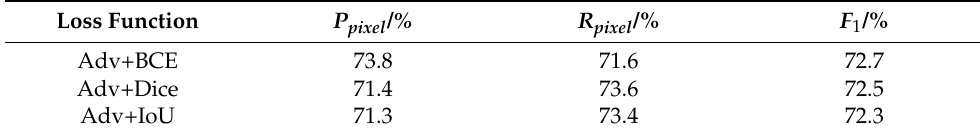
Table 2. The results of different loss functions. Loss